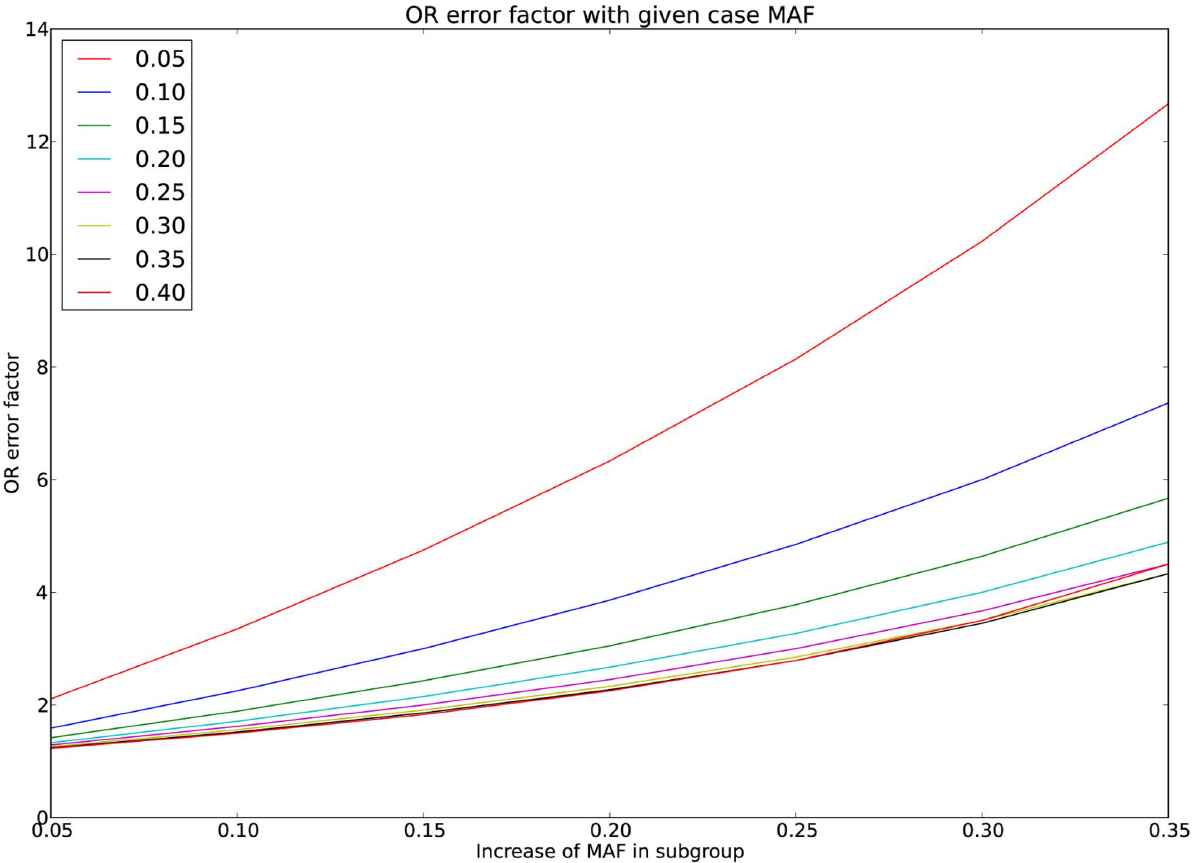
Figure 3. Error factor in ORs. OR error factor present with various minor allele frequencies. Each curve represents the range of OR error factors due to subgroups for a given MAF (minor allele frequency) observed in all cases. The Y-axis indicates the OR error factor corresponding to an increase in the subgroup MAF (as compared with all cases) given by the X-axis. For example, in the second curve corresponding to a MAF of 0.10 in cases, a subgroup with an increase of MAF of 0.20 (or 0.30 MAF) would have an OR in that subgroup approximately four times that reported for the overall group.